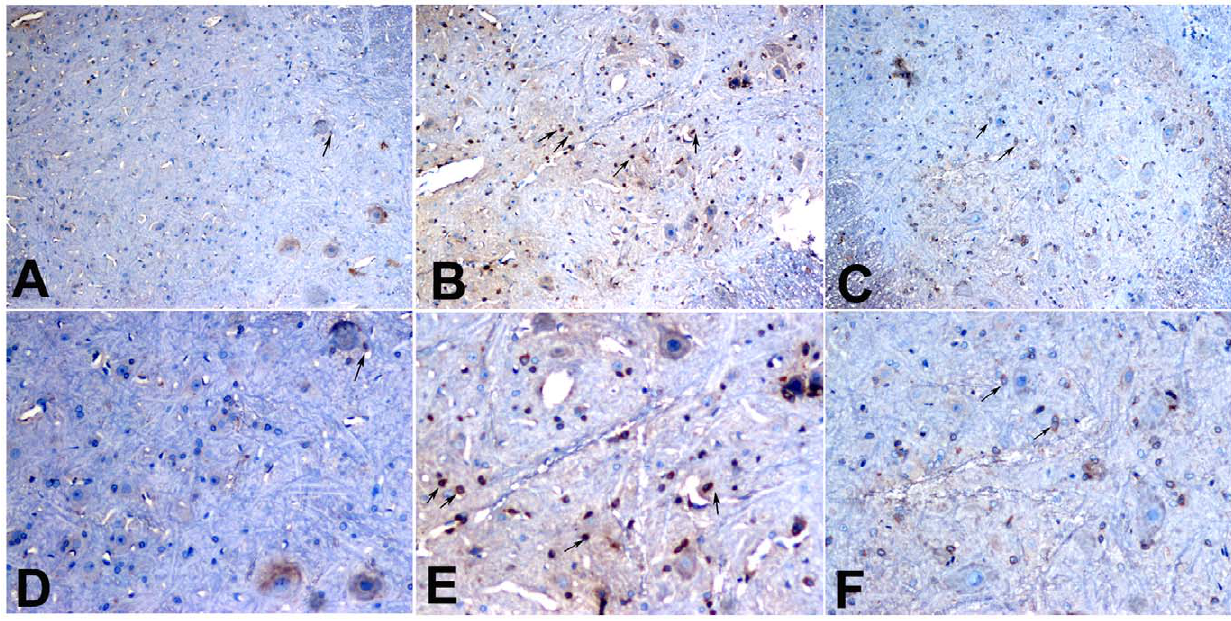
Figure 5. Immunohistochemical analysis of fascin expression in the spinal cord. Fascin staining was more intense in the chronic morphine exposure group than in the control group (A, D). In the LV-shPKCa˜ group (C, F), fascin staining was significantly attenuated compared with the LV-NC group (B, E). Magnification: A, B, C 100 6 ; D, E, F 200 6 .